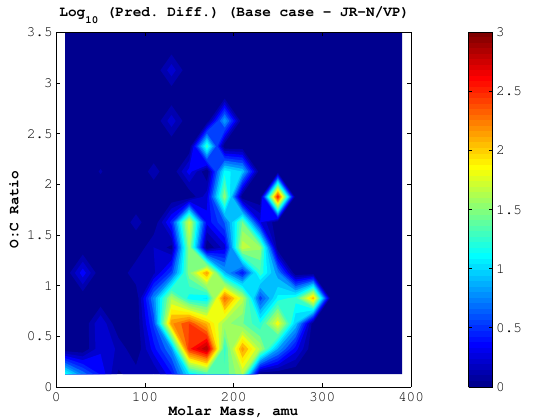
Fig. 6. The plot showing the factor difference in predicted binned organic condensed moles using the vapour pressure models shown in Fig. 5. The Z axis is the base 10 logarithm of the factor(JR- N/VP divided by N-N/VP) in the cumulative concentration of the condensed components (in moleculescm − 3 ) with negative values given a value of zero on this scale.